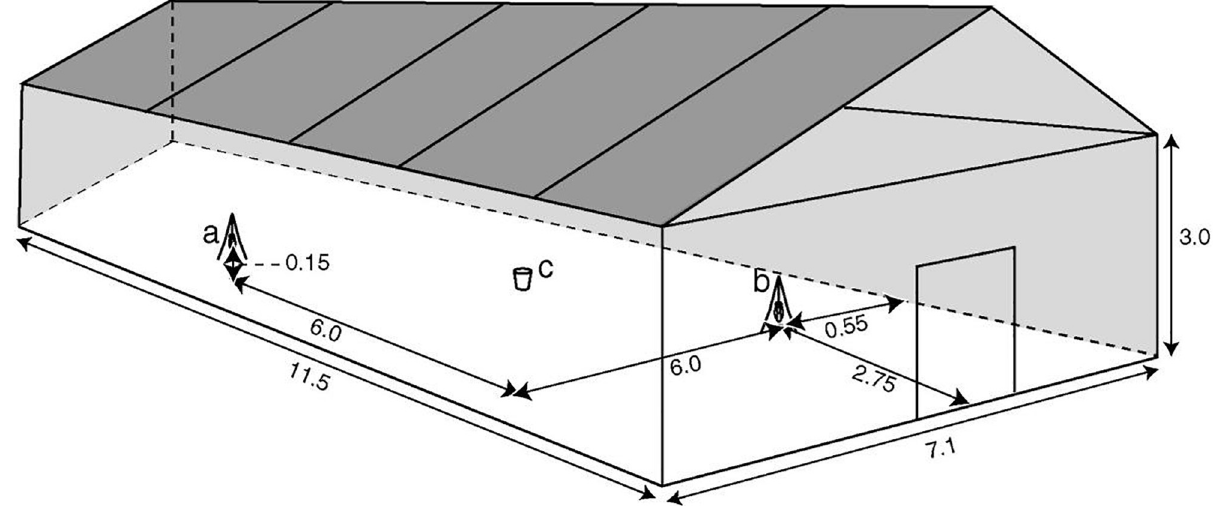
Fig 1. Diagonal arrangement of test and control CFG traps and mosquito release point. a and b represent the CFG traps at 2 different locations with the cup (c) at equidistant point from each of the traps in the screen house.